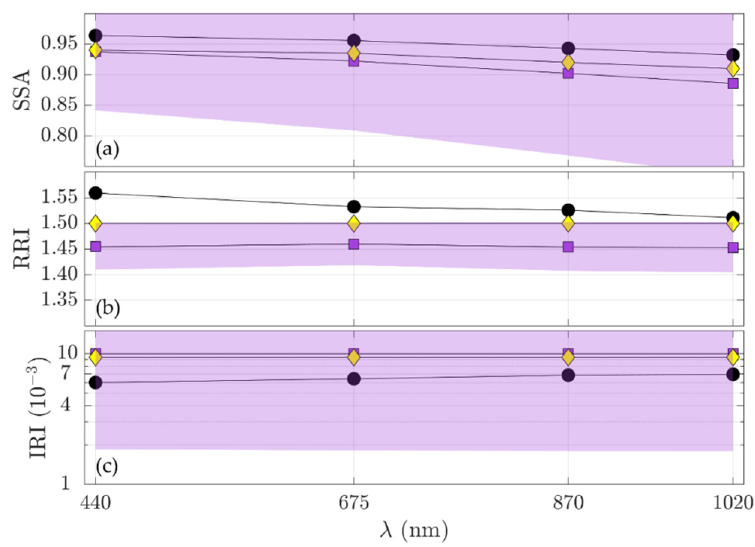
Figure 4. Spectrally-resolved ( a ) single scattering albedo (SSA), ( b ) real refractive index (RRI), and ( c ) imaginary refractive index (IRI) obtained from AERONET (black dots) and GRASP (purple squares) on 8 September 2017 at 09:23 UTC (BB case with AOD 440 ≥ 0.40). GRASP errors are shown by the shaded areas for each retrieved property. For comparison, statistical values as reported in [57] of those variables for BB particles are shown with yellow diamonds.